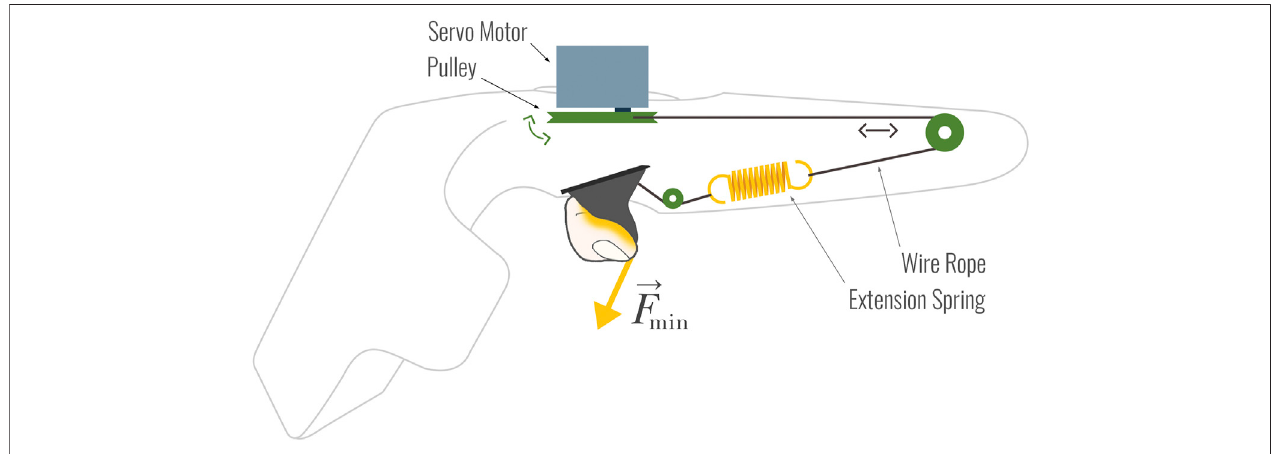
FIGURE 5 | Schematic illustration of Triggermuscle ’ s spring mechanism utilising an extension spring.